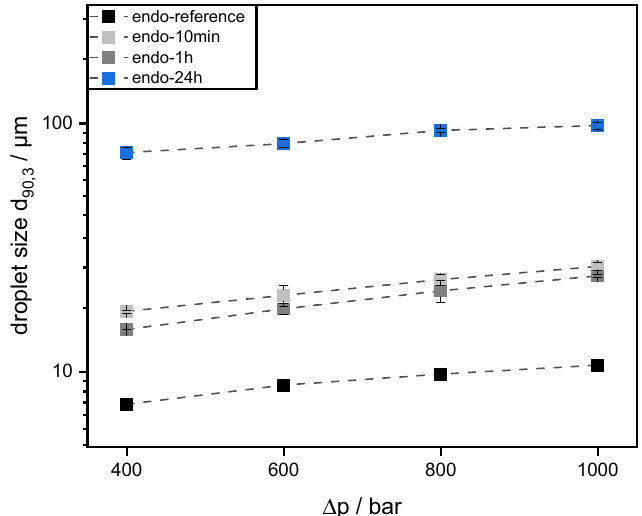
Figure 4. Droplet sizes d 90,3 of emulsions prepared with 0.5 wt% sugar beet pectin with or without (endo-reference) enzymatic modification using endo -polygalacturonanase. The pectins were enzymatically treated for 10 min (endo-10min), 1 h (endo-1h), and 24 h (endo-24h), respectively. The emulsions were prepared at pH 3 with 30 wt% mct oil at varying energy densities.